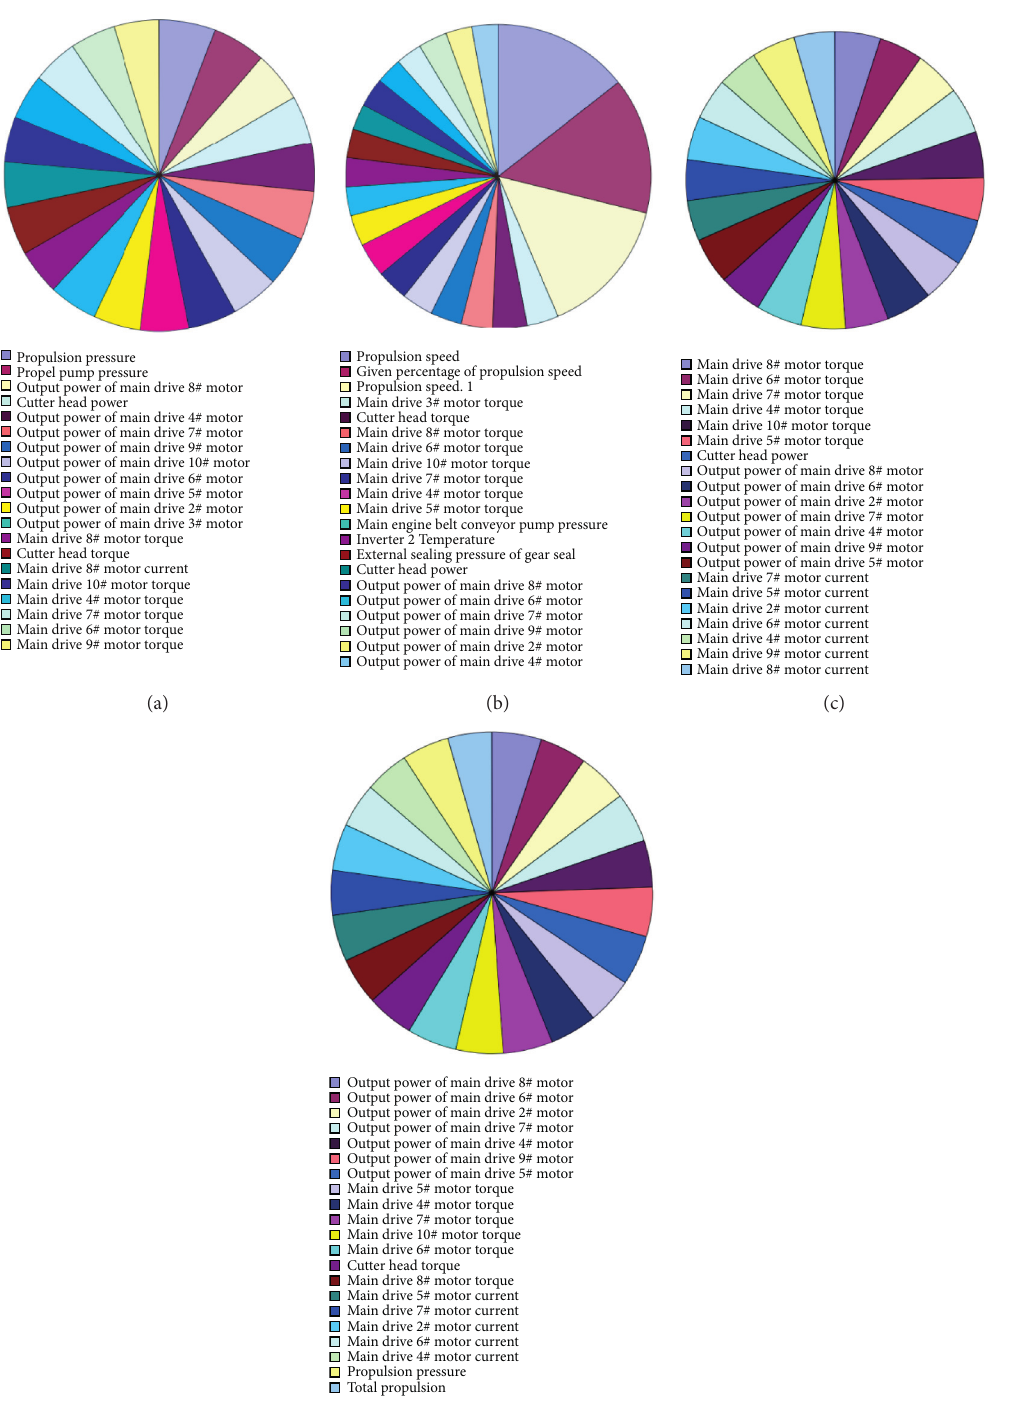
Figure 3: Identification results of input features of Bi-GRU model. (a) Model identification result of total thrust. (b) Model identification result of penetration. (c) Model identification result of cutterhead torque. (d) Model identification result of cutterhead